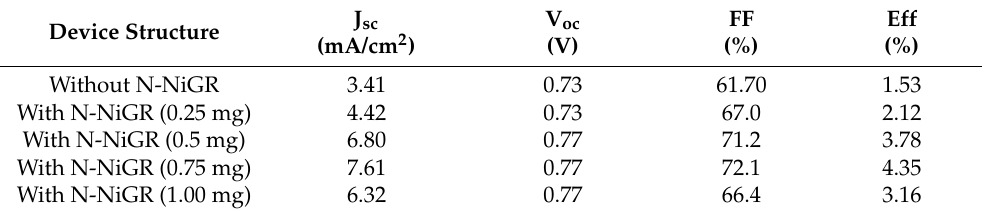
Figure 5. ( a ) Cell’s structure of Glass/ITO/PEDOT:PSS/(SnS + PBT7 + N-NiGR)/ZnO/ EGaIn and ( b ) the J-V curves of the cell without and with N-NiGR NPs with different of concentration (wt.%). Table 1. Device parameters such as PCE (power conversion efficiency), Voc (open circuit voltage), Jsc (short circuit current density), and FF (fill factor) from J–V characteristics without and with different of N-NiGR concentration under illumination at 100 mW/cm 2